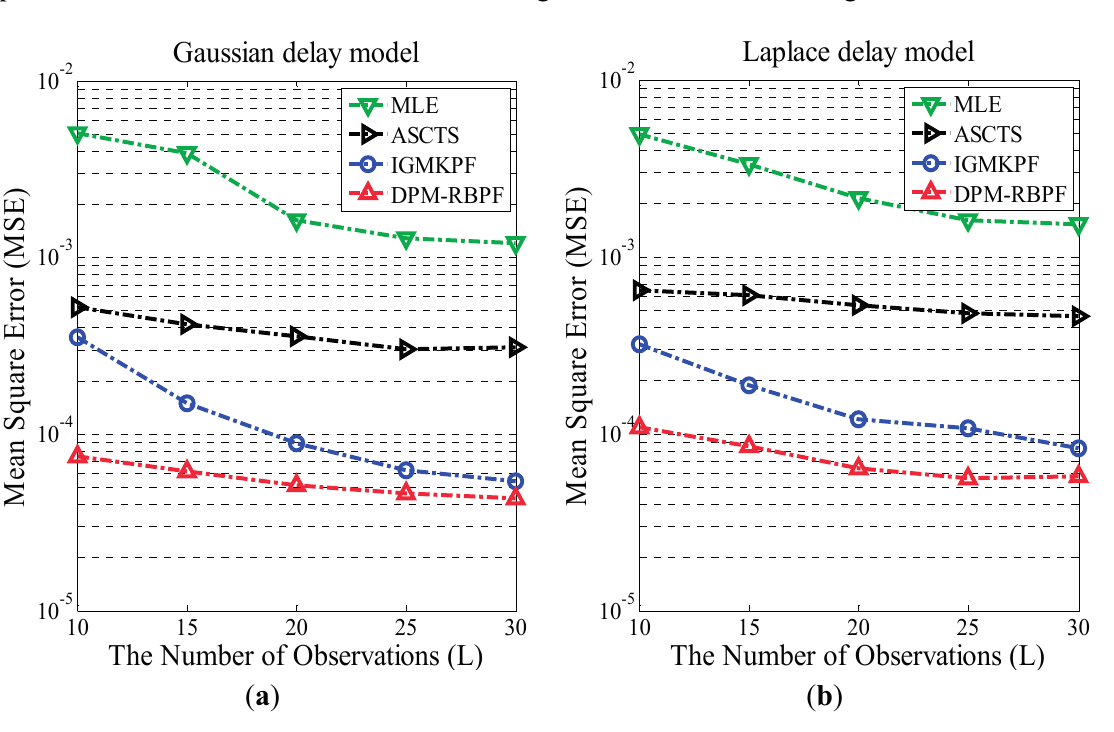
Figure 3. ( a ) MSE of clock offset estimators for symmetrical Gaussian delay; ( b ) MSE of clock offset estimators for symmetrical exponential